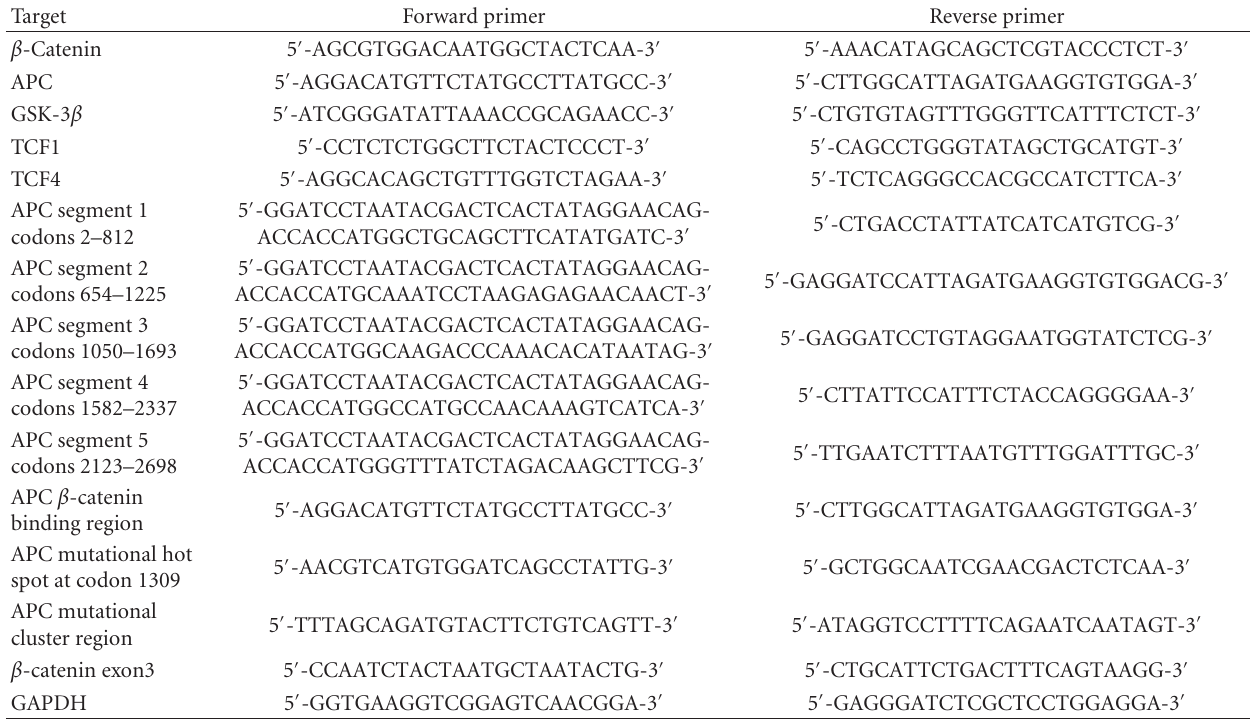
Table 1: Primer sequences used for